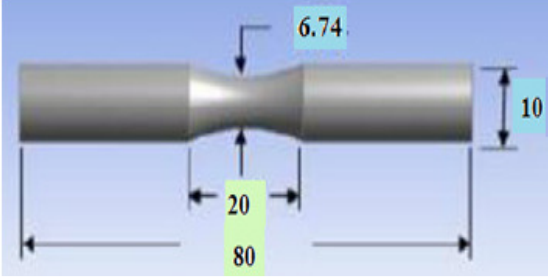
Fig. 2. The specimen dimensions in mm according to (DIN 50113) standard values